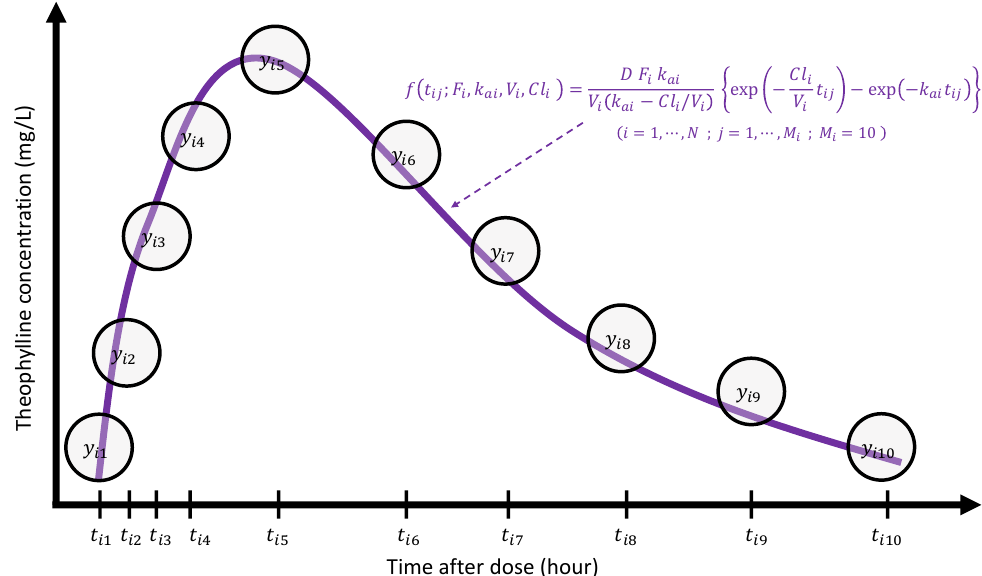
Figure 7. Pictorial illustration of PK modeling for the theophylline